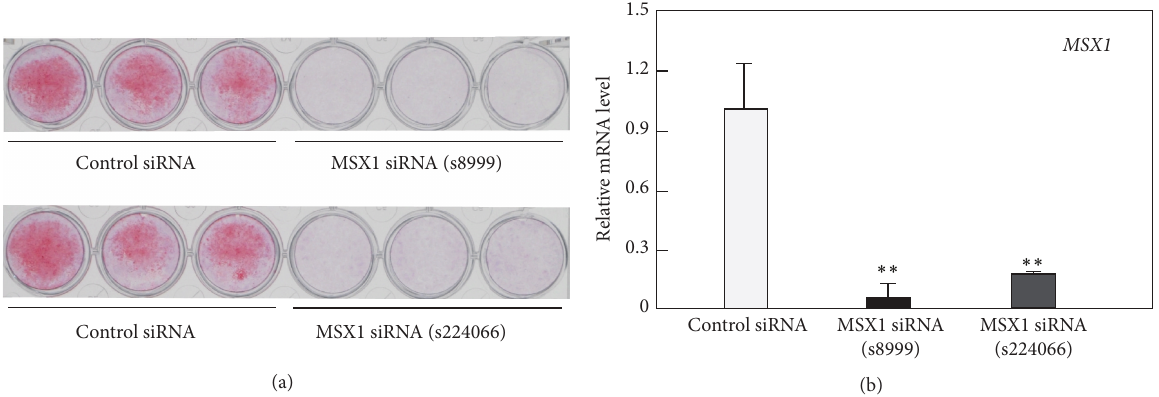
Figure 2: Effects of MSX1 knockdown on calcification of hDPSCs. hDPSCs were transfected with either MSX1 siRNA (s8999 or s224066) or control siRNA and incubated for 2 days in growth medium before the cultures became confluent. Thereafter, the cultures were exposed to osteogenesis-induction medium. (a) The calcified matrix was stained with alizarin red on day 14. (b) MSX1 mRNA level was quantified by RT-qPCR at 48 h after transfection. Values are averages ± SD for three cultures. ∗∗ 𝑃 < 0.01 .